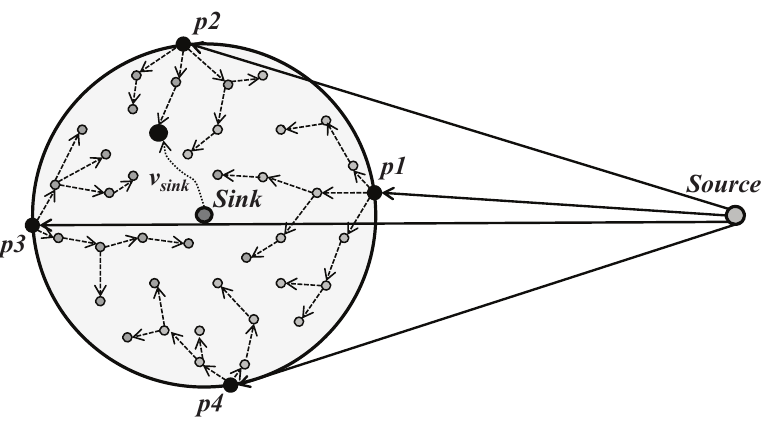
Figure 3. Real-time data routing based on distributed flooding at multiple flooding